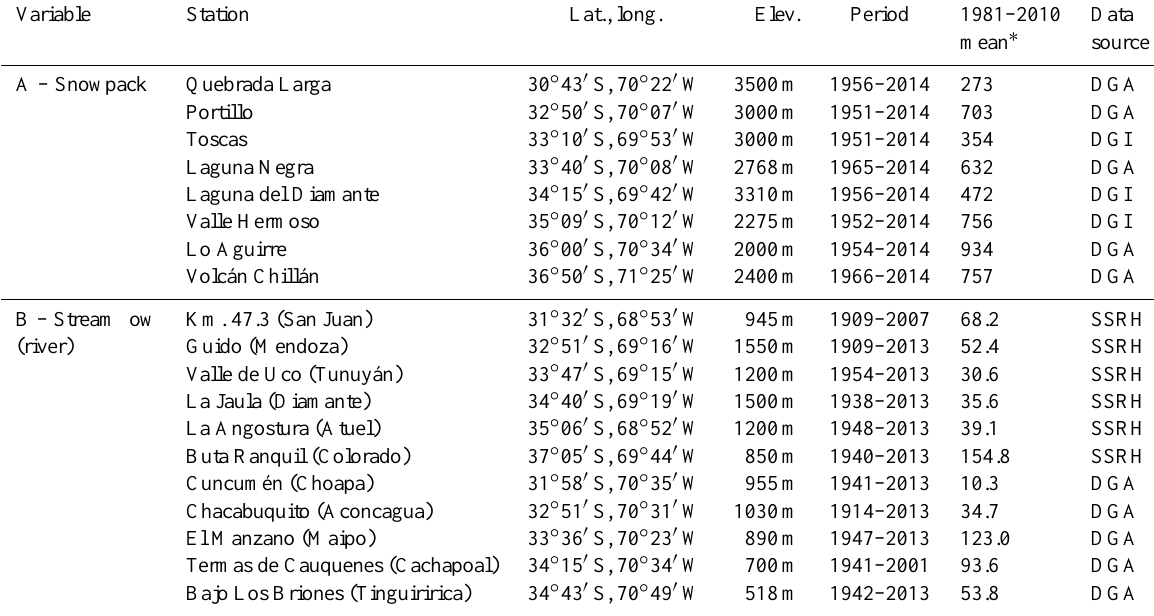
Table 3. Stations used to develop regionally averaged series of mean annual river discharges and winter-maximum snow accumulation for the Andes between 30 and 37 ◦ S. Mean annual streamflow values refer to a July–June water year.